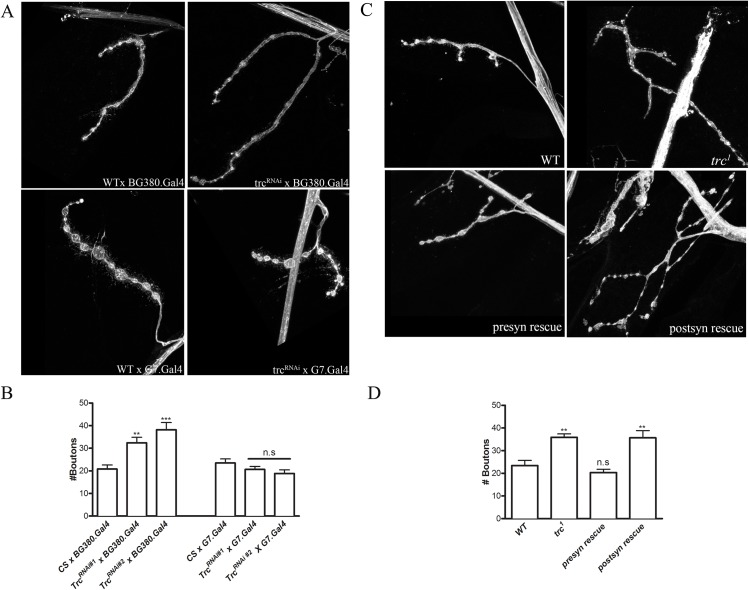
Trc acts presynaptically to regulate synaptic bouton number.
A. Representative images of wild type (WT), trc
RNAi expressed presynaptically (trc
RNAi X BG380.Gal4) stained with anti-HRP antibody. Bottom Panel: Wild Type (trc
RNAi X G7.Gal4) and Trc RNAi driven postsynaptically (trc
RNAi X G7.Gal4) stained with anti-HRP antibody. B. Quantification of synaptic bouton numbers from genotypes in A. C. Representative confocal images from WT (Wild Type), trc mutant (trc
1), trc transgene driven presynaptically using BG380.Gal4 (Presyn rescue) and trc transgene driven postsynaptically using G7.Gal4 (postsyn rescue) stained with anti-HRP antibody. D. Quantification of synaptic bouton numbers from genotypes in C.